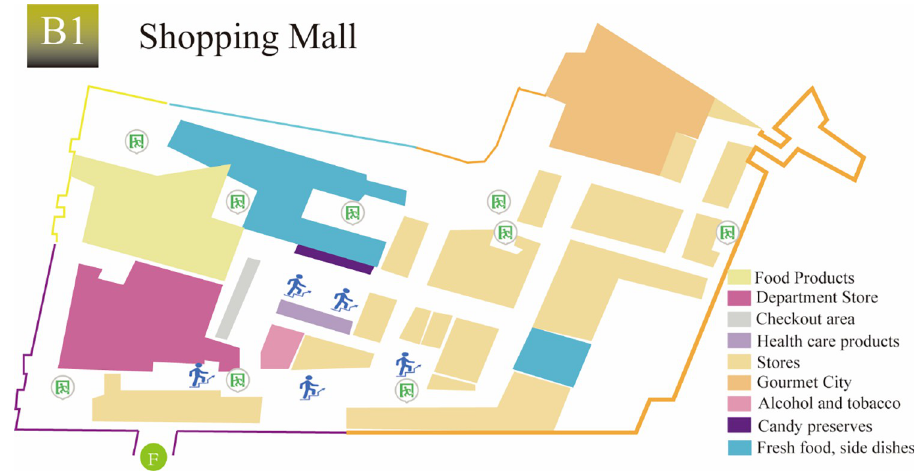
Fig 3. Shopping center B1 floor